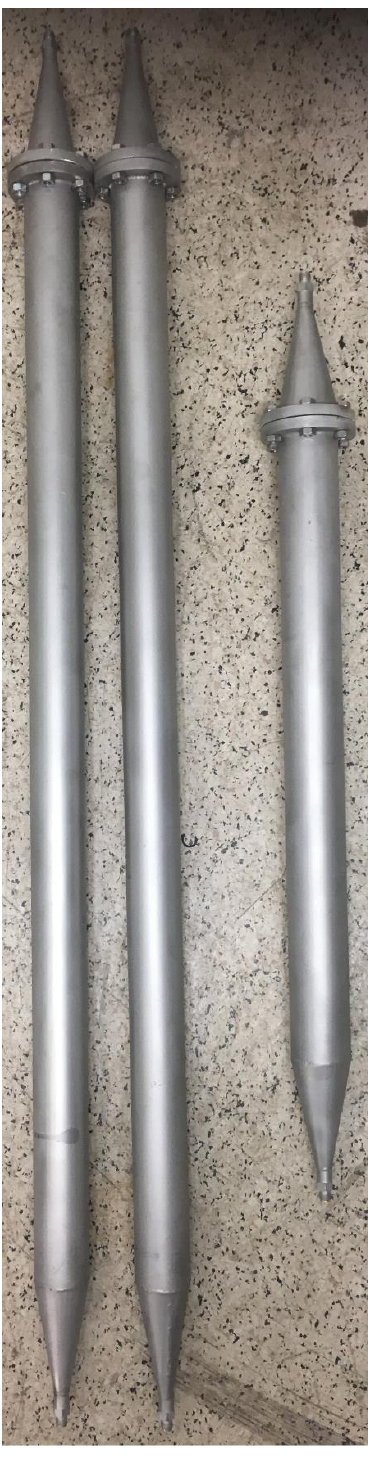
Figure 4. The final vaporizer vessels compared to the hydrogenation reactor.